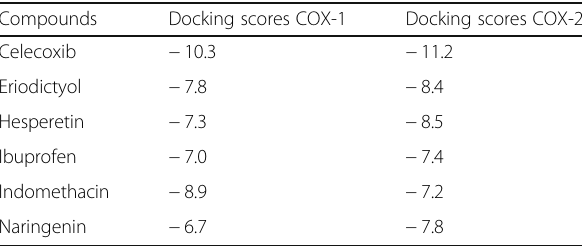
Table 1 Docking scores of the lead, other flavanones (Hesperetin and Naringenin), and the standard drugs